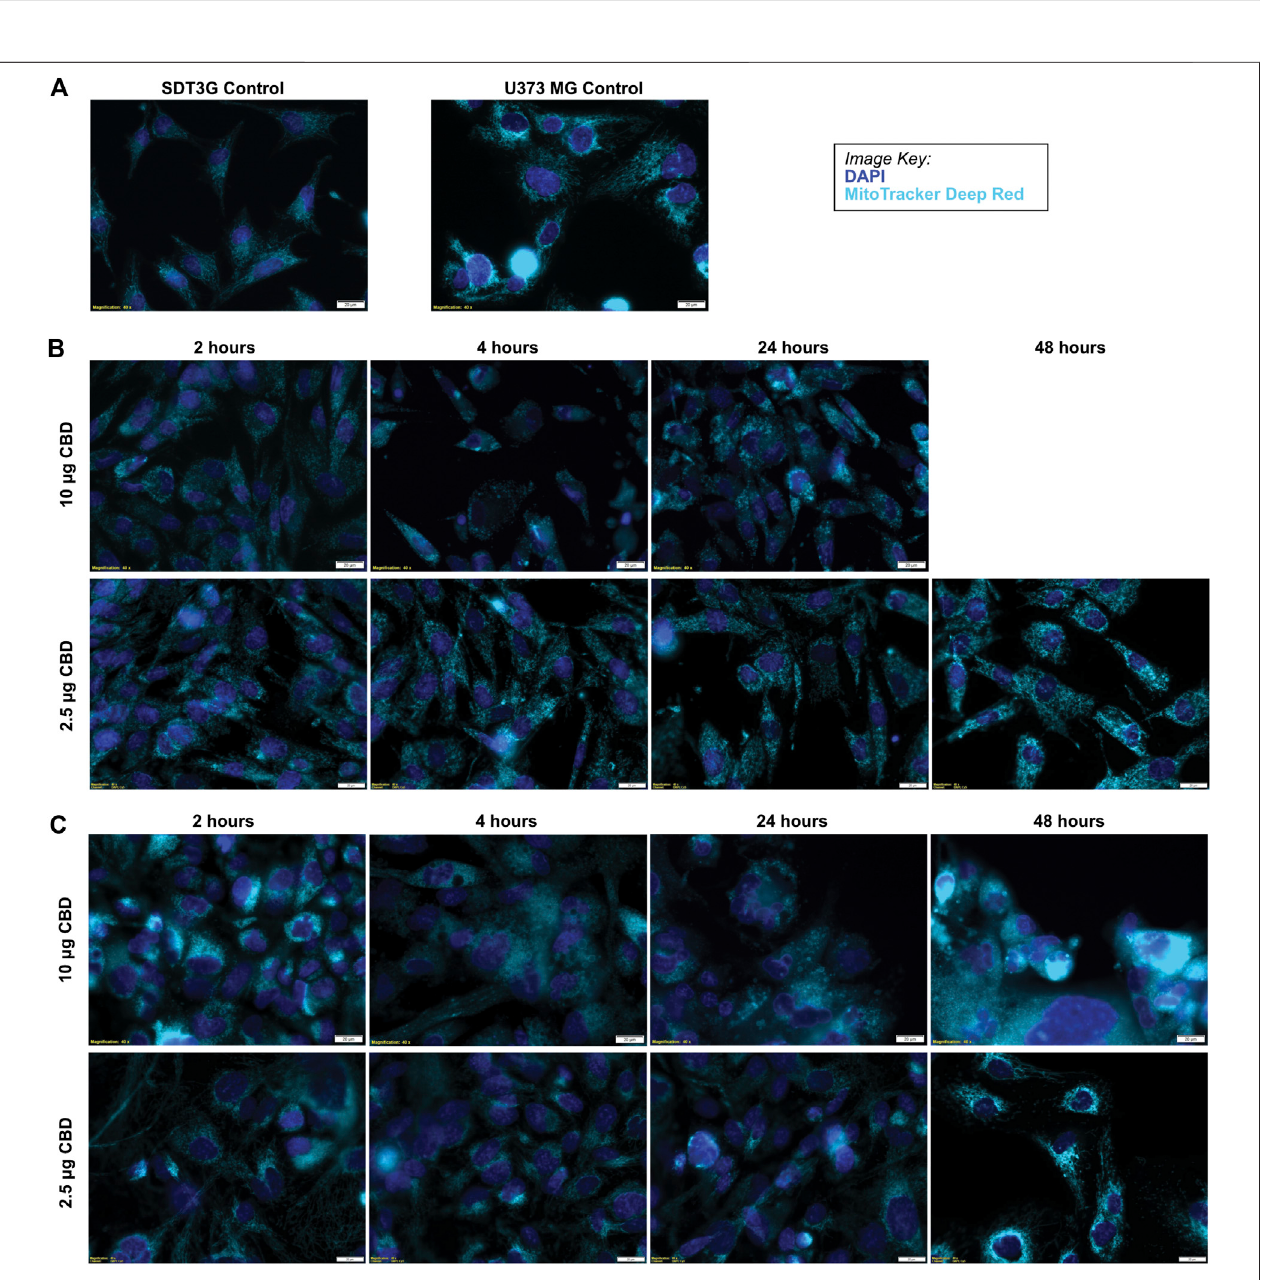
FIGURE 4 | CBD causes morphological changes in mitochondria. (A) Untreated SDT3G and U373 MG cells demonstrate a fi brillar mitochondrial network. Followingtreatment with CBD, both SDT3G (B) and U373 MG (C) cells show dramatic changesin mitochondrial morphology within 2 hours of10 μ g/ml CBD treatment that is not observed at 2.5 μ g/ml CBD. Nuclei are represented by dark blue and mitochondria are represented by cyan pseudo colors.